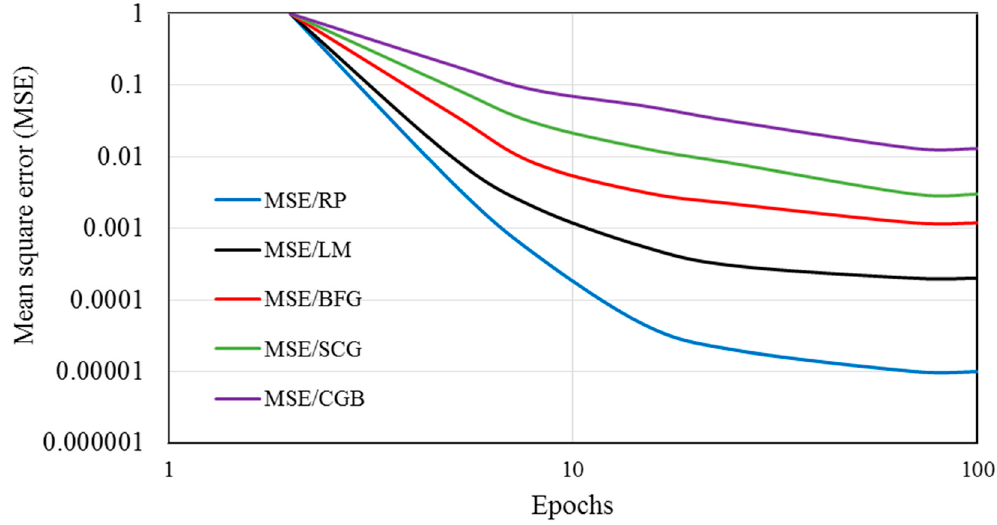
Figure 10. Convergence of NN results for train sets based on different Figure 10. convergence of NN results for train sets based on different algorithms.